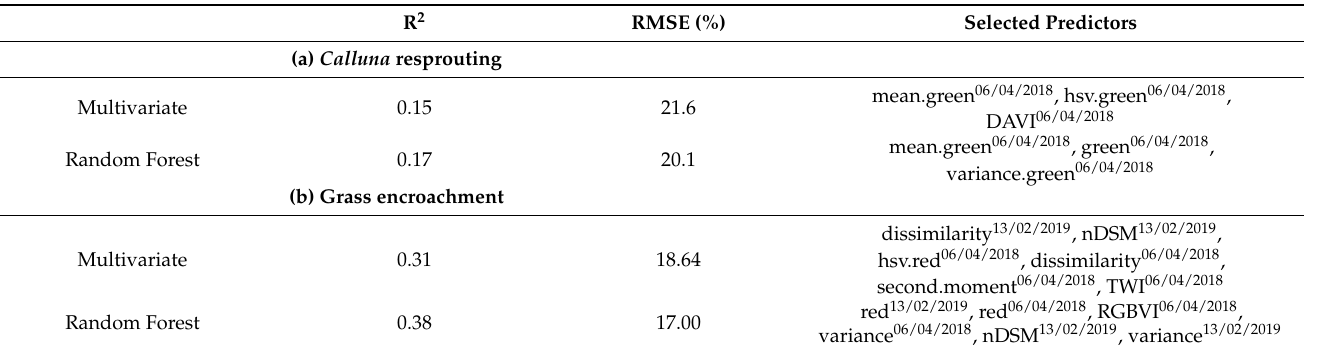
Table 5. Model validation after predictor variable selection for the two response variables: a) Calluna resprouting and b) grass encroachment using two modeling techniques based on n = 1200 samples and n = 100 validation splits. R 2 RMSE (%) Selected